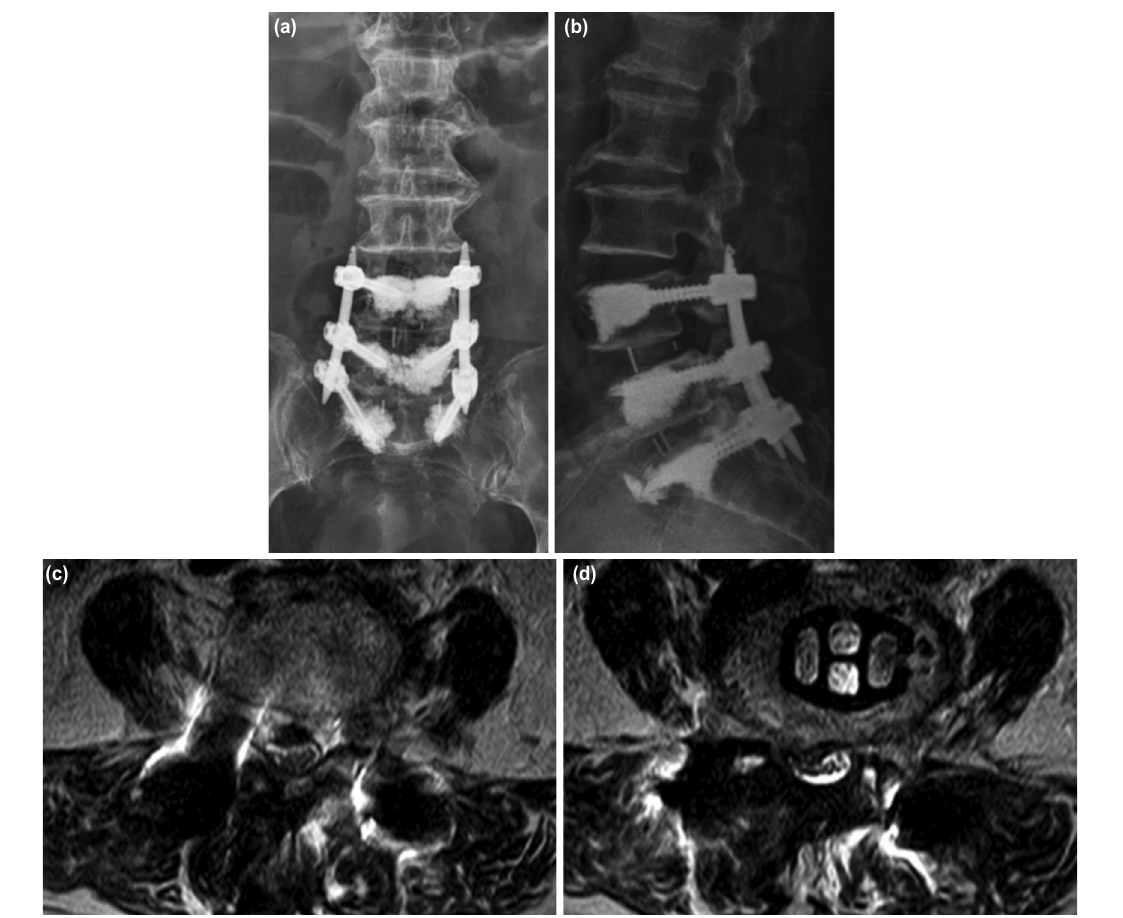
Postoperative radiograph and MRI image at the second surgery (ALIF). (a) AP, (b) lateral, (c) L4 posterior arch level, (d) an at L4- Fig. 3: L5